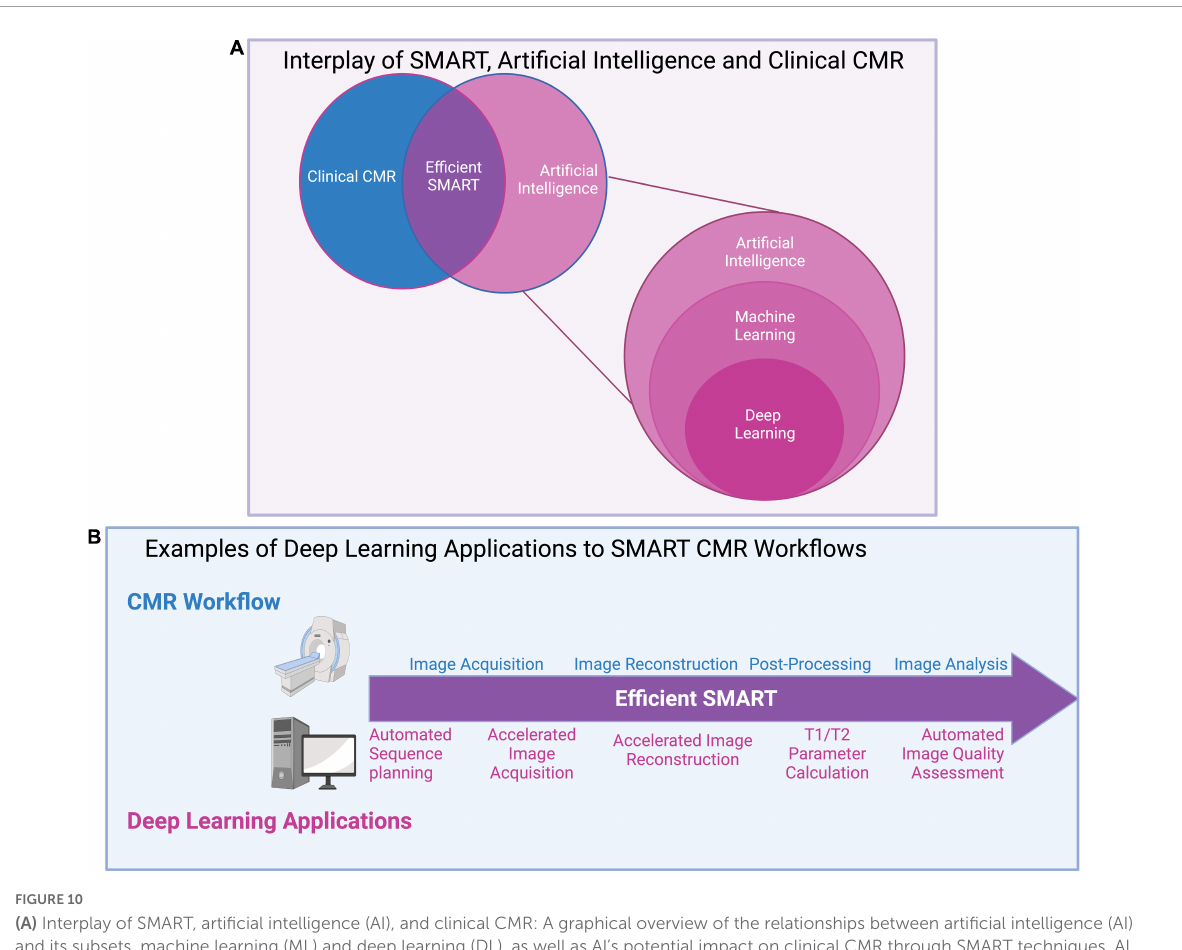
FIGURE10 (A) Interplay of SMART, artificial intelligence (AI), and clinical CMR: A graphical overview of the relationships between artificial intelligence (AI) and its subsets, machine learning (ML) and deep learning (DL), as well as AI’s potential impact on clinical CMR through SMART techniques. AI uses machines to perform tasks usually disposed to humans and covers all ML techniques. ML specifically investigates how computers learn from data, and DL, the most popular ML technique, automatically learns important features of data. (B) Examples of deep learning applications to SMART CMR workflows: DL has been applied at all stages of the CMR workflow, from image acquisition to analysis. Advantages to DL applications include reductions in input needed from clinicians through automated methods, and significant reductions in time for acquisition, reconstruction, and analysis. Challenges remain in applying DL to clinical settings, include computational limits, the lengthy training required for DL networks, and the “black box” nature of